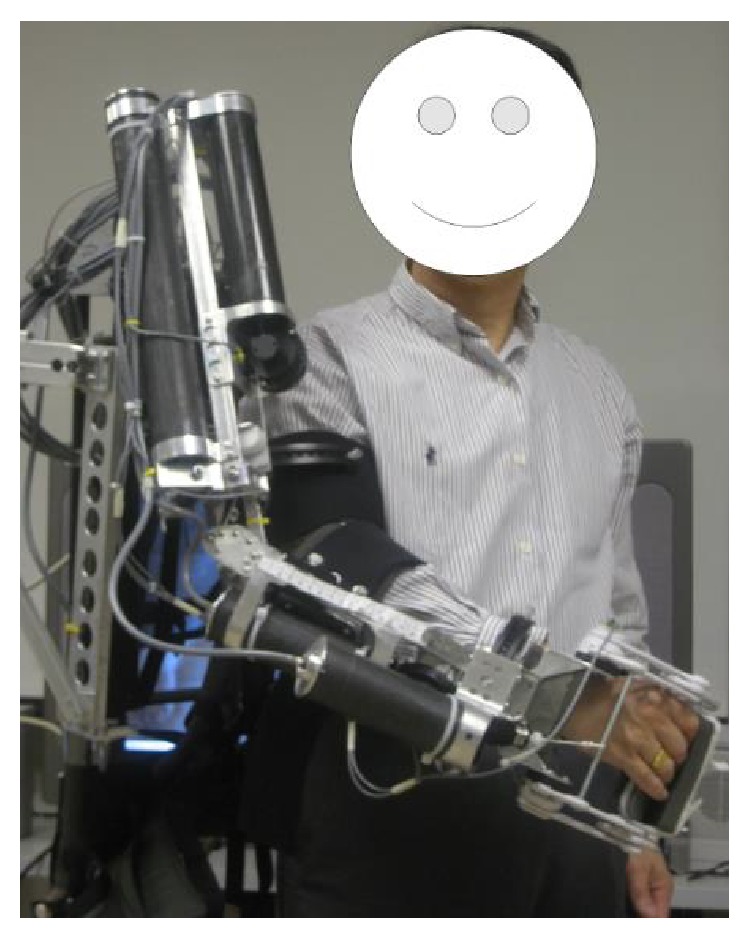
The diagram of the subject wearing the 5-DOF RUPERT [6].